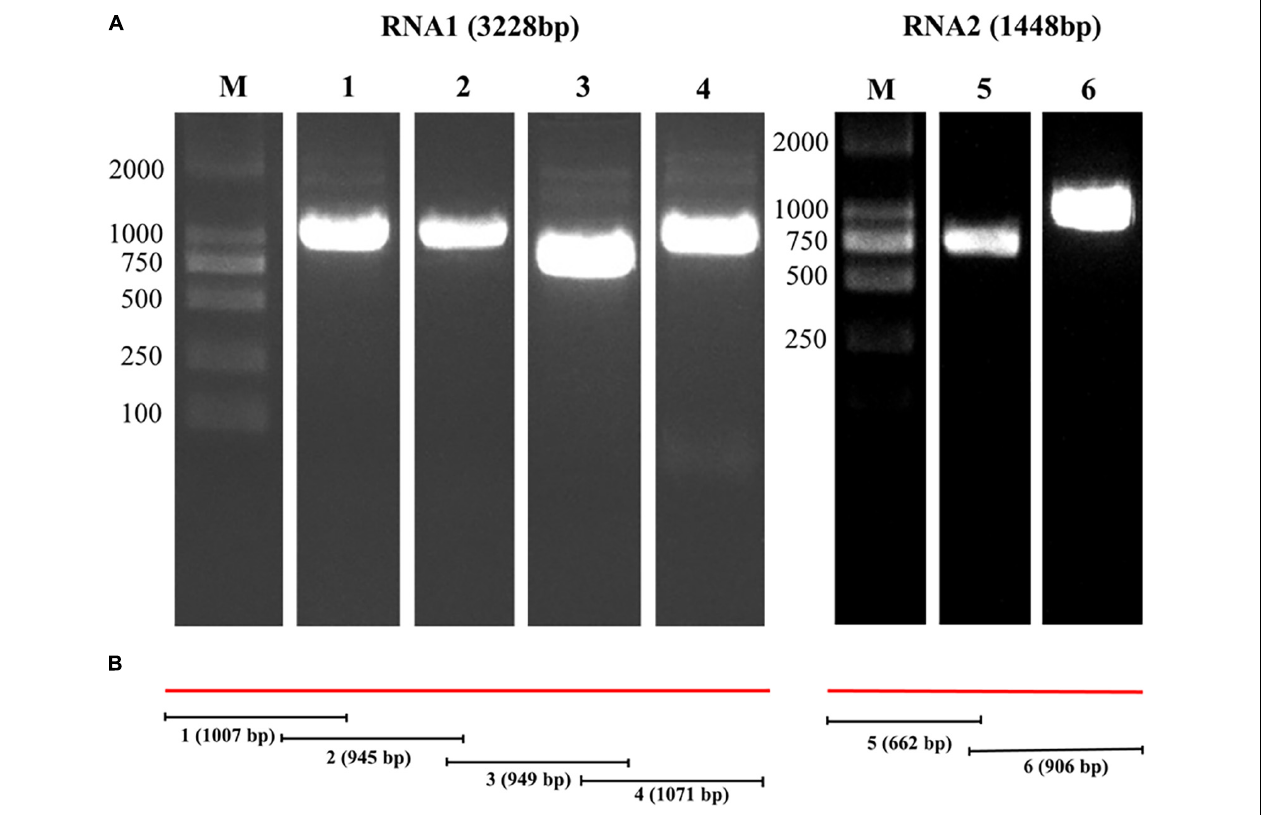
FIGURE 3 | Assembly strategy and agarose gel electrophoresis of RT-PCR products of CMNV RNA1 and RNA2 segments from Larimichthys polyactis . (A) Agarose gel electrophoresis of RT-PCR products for cloning of the CMNV RNA1 and RNA2 strands. The images are cropped from the original image ( Supplementary Figure 1 ). Lane M: 2,000 bp marker. Lanes 1–4: amplicons generated from the CMNV RNA1 with primers RNA1-F1/R1, RNA1-F2/R2, RNA1-F3/R3, and RNA1-F4/R4, respectively. Lanes 5–6: amplicons produced from RNA2 using primers RNA2-F1/R1 and RNA2-F2/R2. (B) Strategy of cloning and assembling